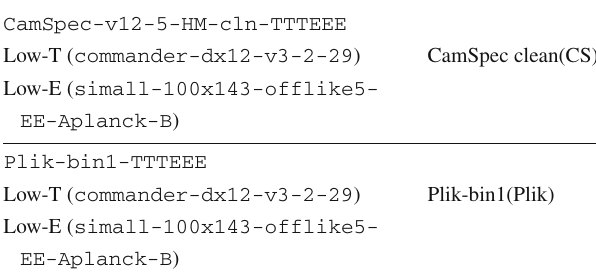
Table 2 Short hands used for the combination of Planck likelihoods used for the analysis. We have used same low (cid:11) (lowT + lowE) likeli- hoods for both the